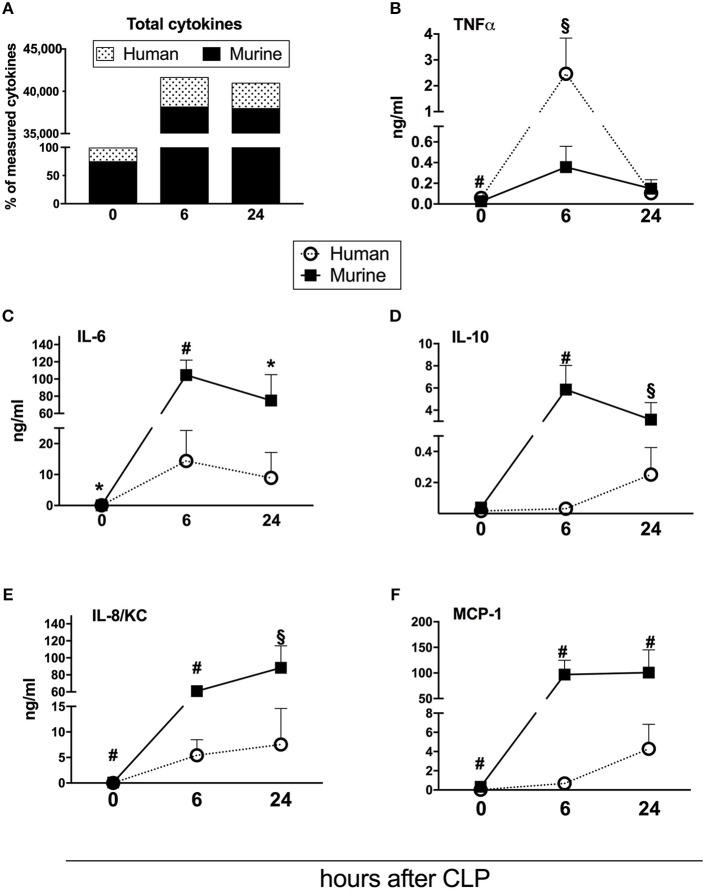
Dynamics of human and murine cytokine responses after CLP regardless of outcome. Graphs present concentration of cytokines from 31 humanized NSG mice subjected to CLP. Dynamics of: (A) combined murine and human cytokines (the sum of both measured at baseline counted as 100%); (B) TNF; (C) IL-6; (D) IL-10; (E) IL-8/KC; (F) MCP-1. BL, baseline. Concentration of human and murine cytokines were compared using Mann-Whitney test at each time-point separately (T0,T6h n = 31, T24 n = 19). *p < 0.05; §p < 0.01; #p < 0.001.